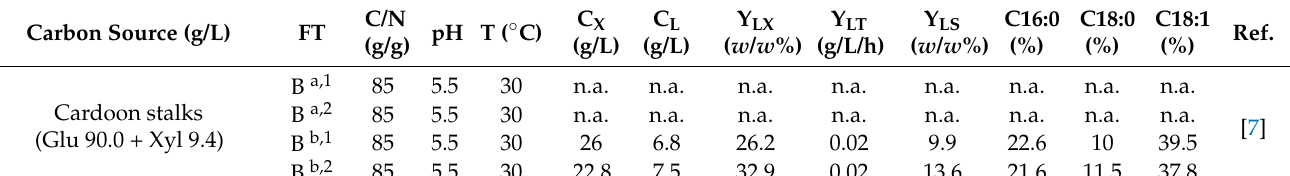
Table 5. Bioconversion of lignocellulosic biomass hydrolysates to single-cell oil by the biocatalyst C. oleaginosus . Carbon Source (g/L) FT Ref.